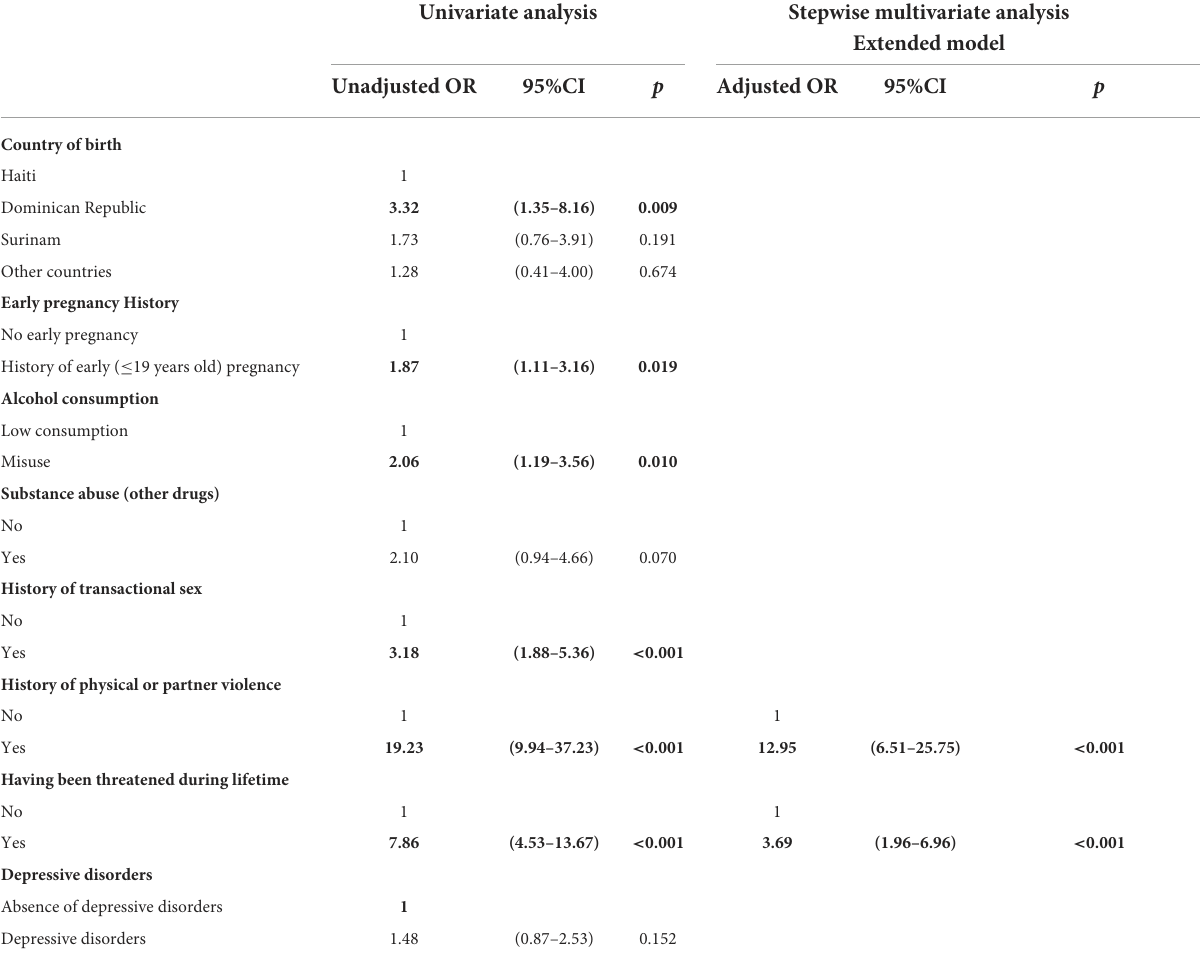
TABLE 3 Univariate and multivariate analyses of factors associated with a history of rape among migrant women attending Red Cross HPCs in 2021, using stepwise logistic regression ( n = 382) AUC = 0.85. Univariate